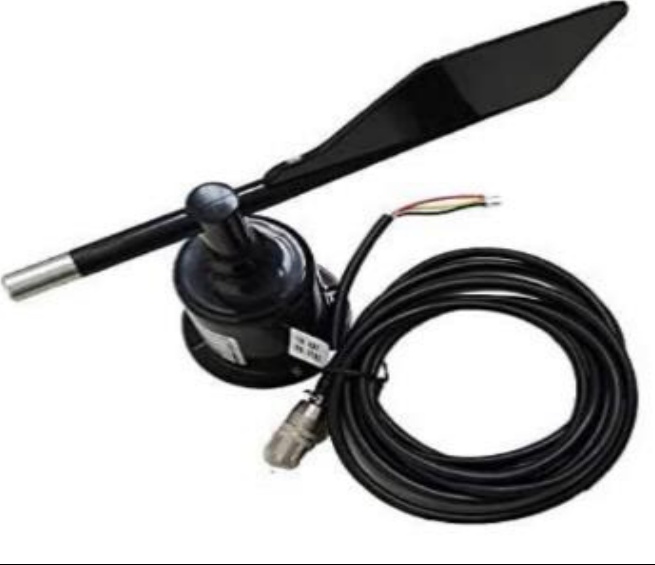
Figure: 14 Wind vane.